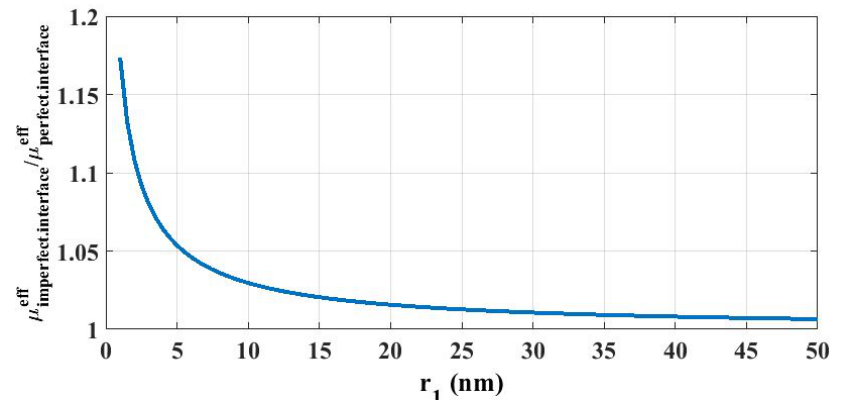
µ eff imperfect.interface µ eff perfect.interface